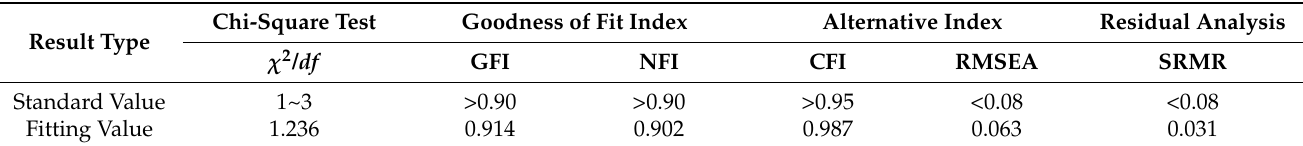
Table 2. Fitting effect evaluation indicators for the structural equation model.